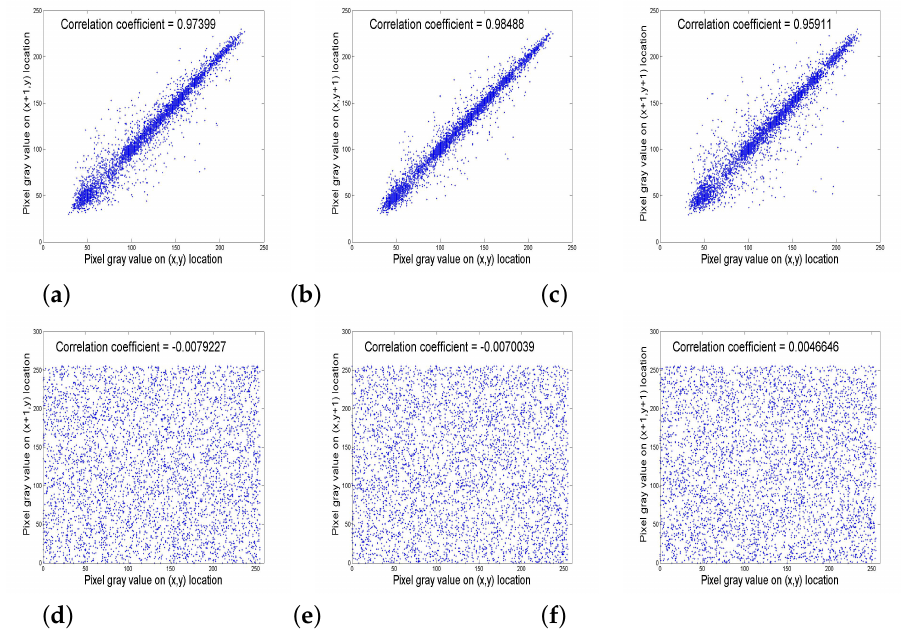
Figure 6. Correlation coefficients of neighbouring pixels for Lena ( 256 × 256 ) image in ( a ) Horizontal, ( b ) Vertical and ( c ) Diagonal directions. Additionally, correlation coefficients of neighbouring pixels for the enciphered image of Lena ( 256 256 ) in ( d ) Horizontal, ( e ) Vertical and ( f ) Diagonal directions.